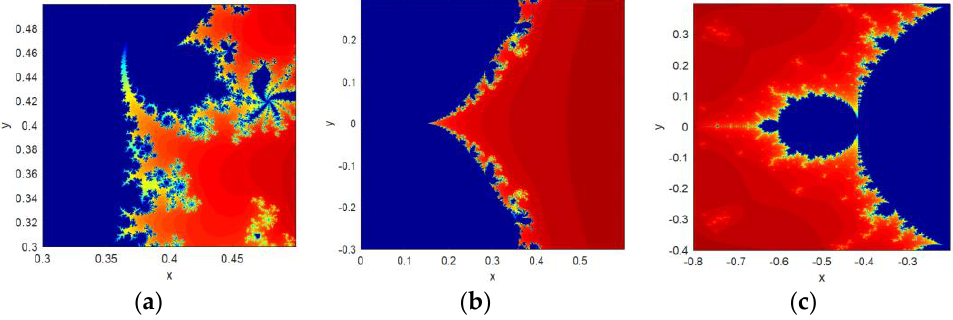
Figure 3. Zoomed version of fractal images generated from CFF: ( a ) 𝛽 = 0.3; ( b ) 𝛽 = 0.5; ( c ) 𝛽 = 0.5.